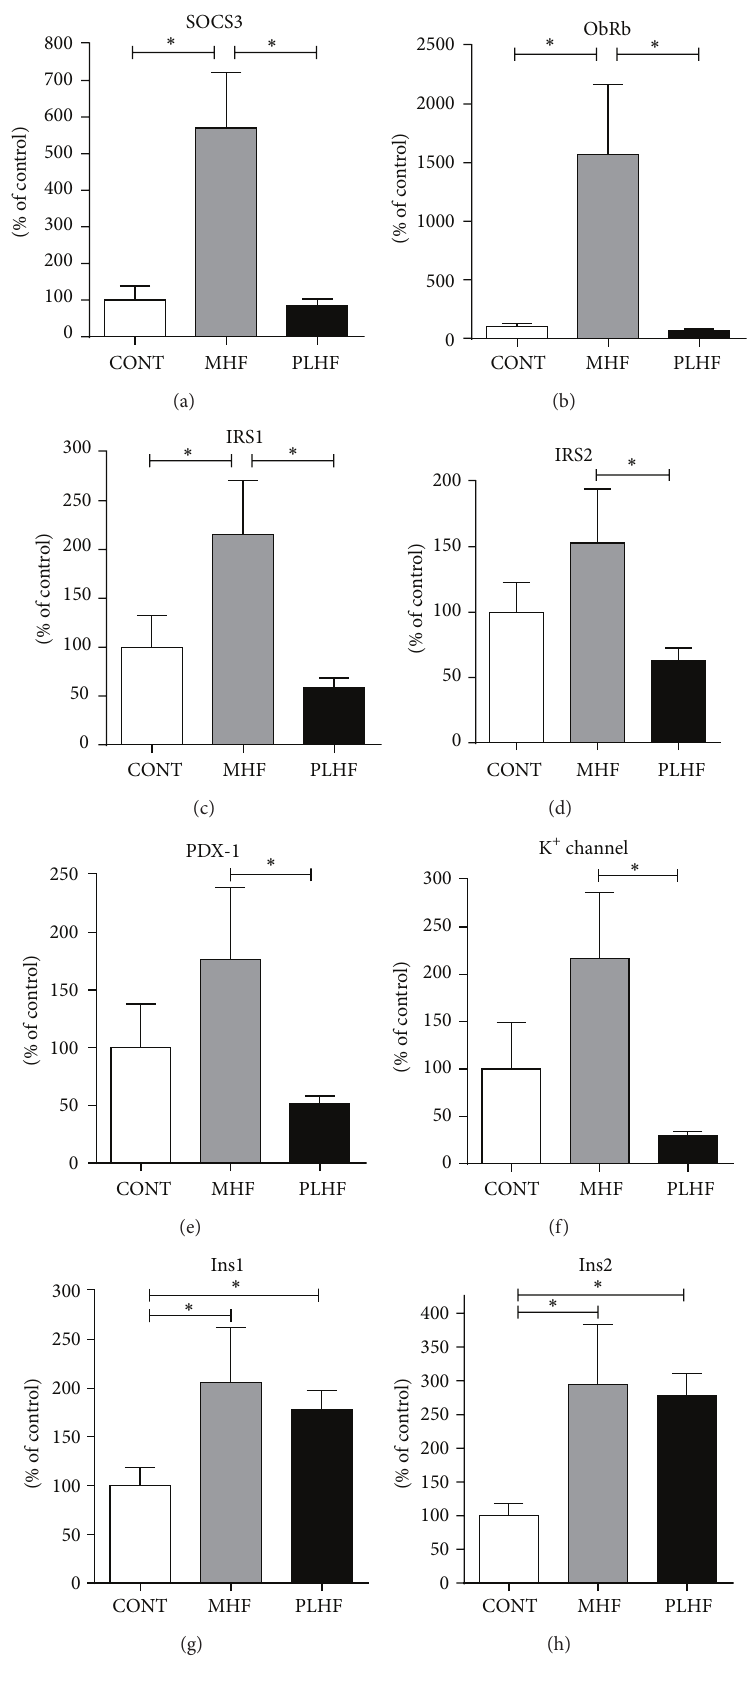
Figure 3: Pancreatic mRNA expression in adult CONT, MHF, and PLHF offspring. SOCS3: suppressor of cytokine signaling 3; IRS: insulin receptor substrate; PDX1: pancreatic and duodenal homeobox 1; ObRb: full length leptin receptor; Ins: insulin; Kir6.2: potassium channel subunit. Data are means ± SEM, 𝑛 = 10–18 per group. ∗ 𝑃 < 0.05